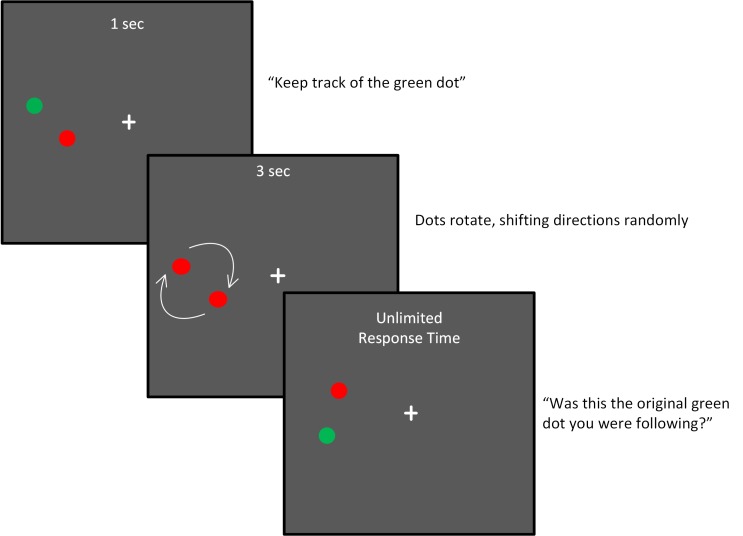
Methods for Experiment 1.Dots rotated at one of four speeds as described in the text, and were placed on either the left or the right of the fixation cross on each trial.